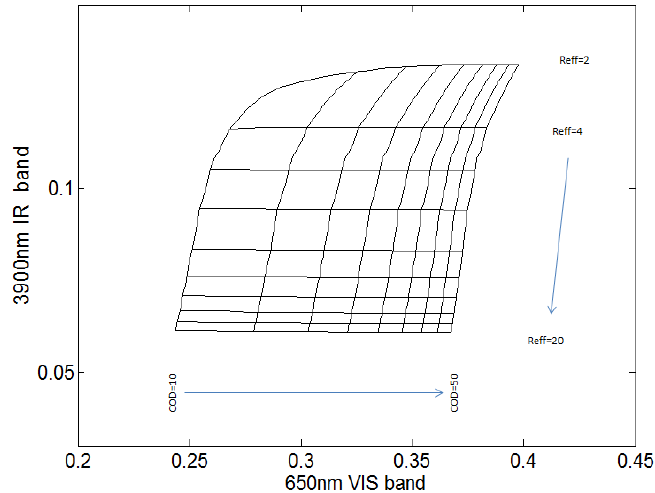
Figure 1. Reflectance sensitivity plot for Visible Infrared Solar-infrared Split Window Technique (VISST) channels assuming water phase